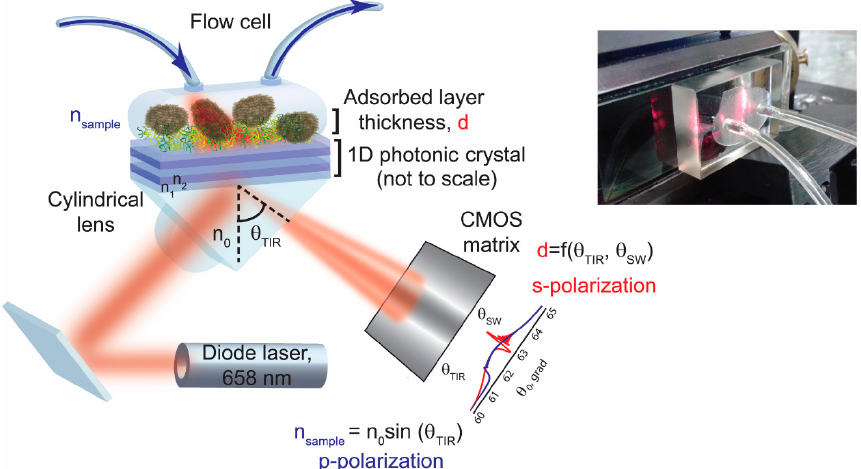
Figure 1. A sketch of the label-free biosensor used for simultaneous measurements of surface and volume effects and based on angular interrogation of two photonic crystal surface waves (PC SWs).